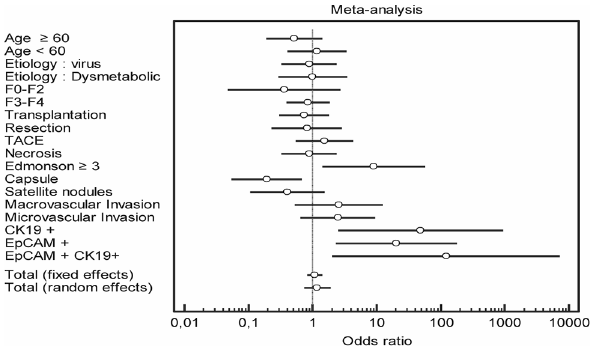
Fig 5. Odds ratio meta-analyses of data from 58 HCC nodules. Meta-analyses were performed on clinical and biological criteria.